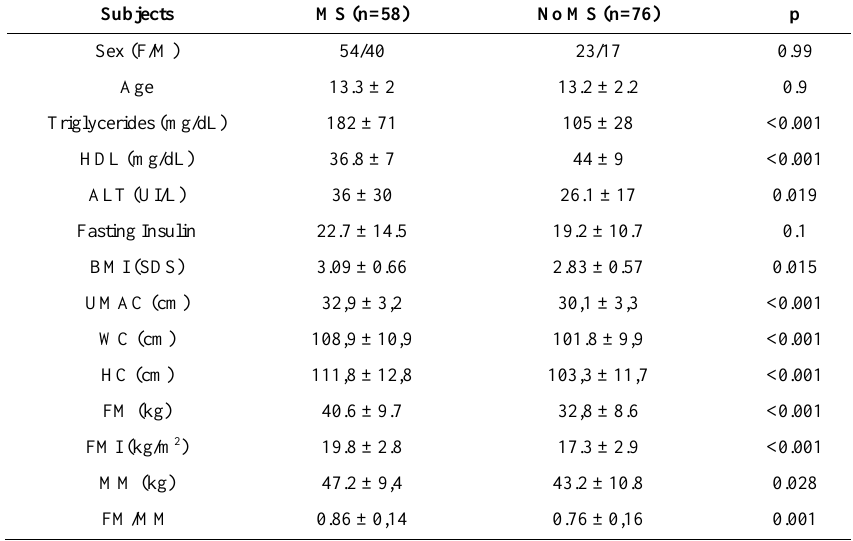
Table 2. Demographic, indirect measurement methods and BIA findings in cases according to MS